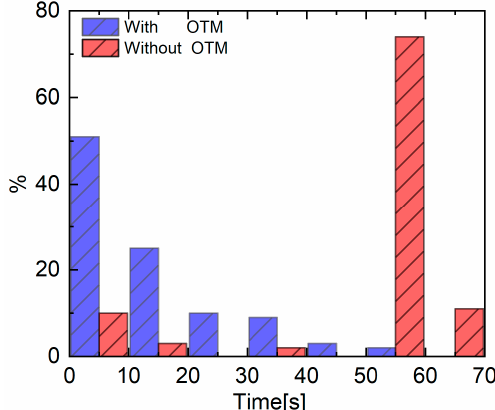
Figure 5. The time distribution comparison of the optimized initial parameters and the unimproved ones to fit the same measured WMS − 2f/1f spectral profile. ones to fit the same measured WMS − 2f/1f spectral